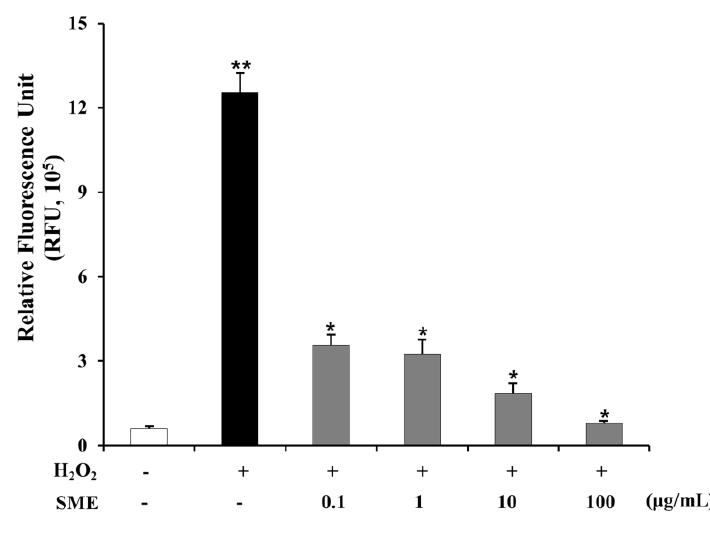
Figure 8. Effct of SME on oxidative stress in LX-2 cells LX-2 cells were either left untreated or pre-treated with SME (0.1-100 μg/mL) for 30 min and then left untreated or exposed to 600 μM hydrogen peroxide (H O ) for 15 min. Intracellular generation of ROS 2 2 was detected by measuring the conversion of 10 µM DCF-DA as described in experimental methods. Values are means ± SD ( n = 9 per group), ** p < 0.01 vs. untreated; * p < 0.01 TGF-β1 vs. SME